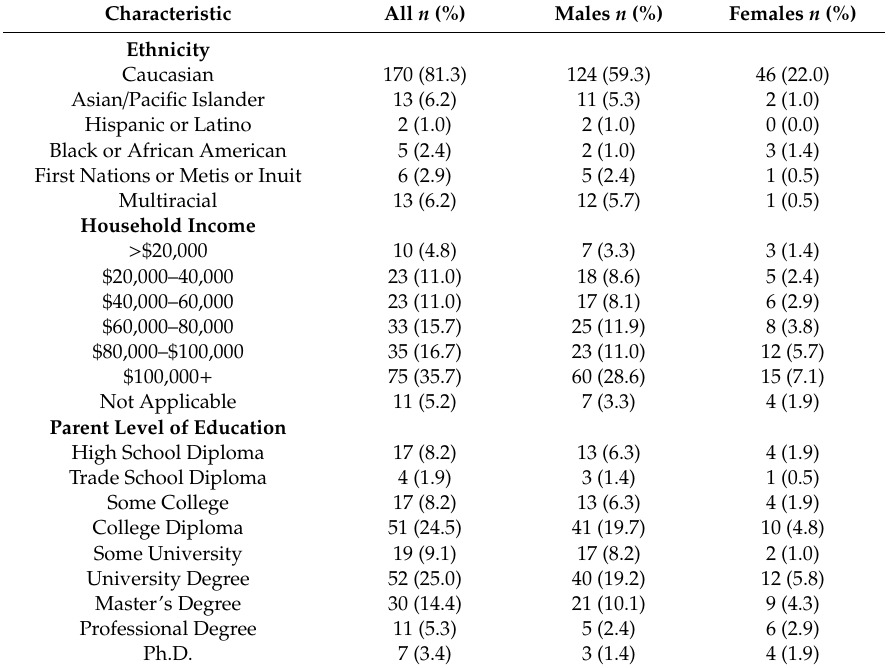
Table 2. Demographic